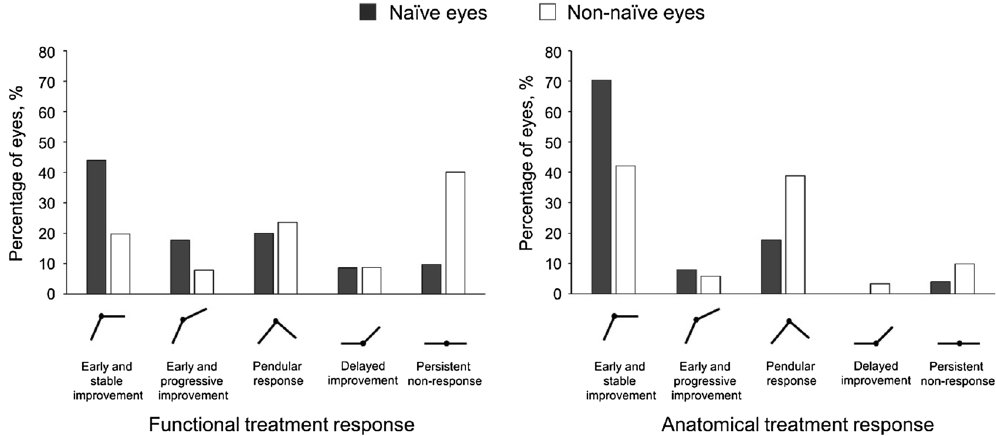
Figure 1. Functional and anatomical treatment response for naïve (black bars) and non-naïve eyes (white bars). Treatment response patterns for functional response (FR) were graded as follows: early and stable improvement (month 2: very good FR or good FR; month 4: ± 4 letters change from month 2), early and progressive improvement (month 2: very good or good FR, month 4: ≥ 5 letters improvement from month 2), pendular response (month 2: very good or good FR, month 4: ≥ 5 letters loss from month 2), delayed improvement (month 2: no FR or severe vision loss, month 4: very good or good FR), persistent non-response (month 2 and month 4: no FR or severe vision loss). Treatment response patterns for anatomical response (AR) were graded as follows: early and stable improvement (month 2: very good, good or limited AR; month 4: CST change ± 10% from month 2 and at least limited AR), early and progressive improvement (month 2: very good, good or limited AR, month 4: CST reduction > 10% from month 2), pendular response (month 2: very good, good or limited AR; month 4: CST increase > 10% from month 2), delayed improvement (month 2: poor or no AR, month 4: very good, good or limited AR) or persistent non-response (month 2 and month 4: poor or no AR, or limited AR at month 2 and poor or no AR at month 4 but CST increase <